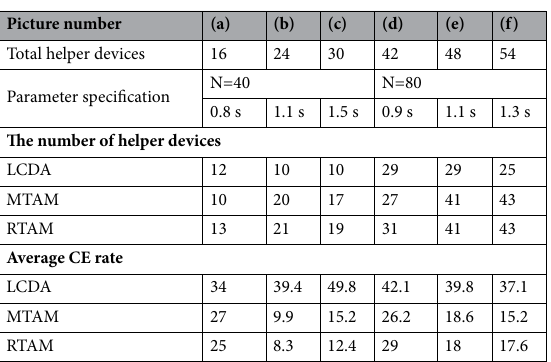
Table 4. The number of helper devices and the average CE rate in different